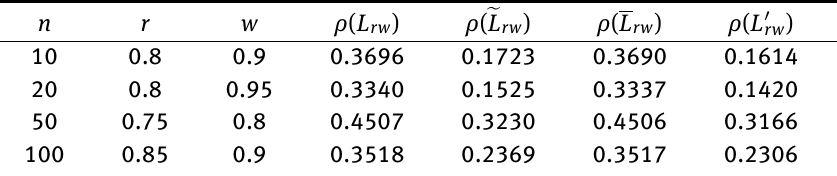
Table 1: Comparison of spectral radius of AOR scheme.